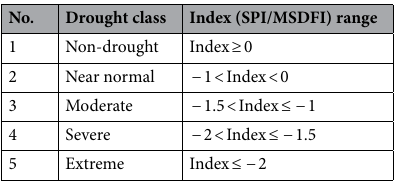
Table 2. SPI 20 and MSDFI drought